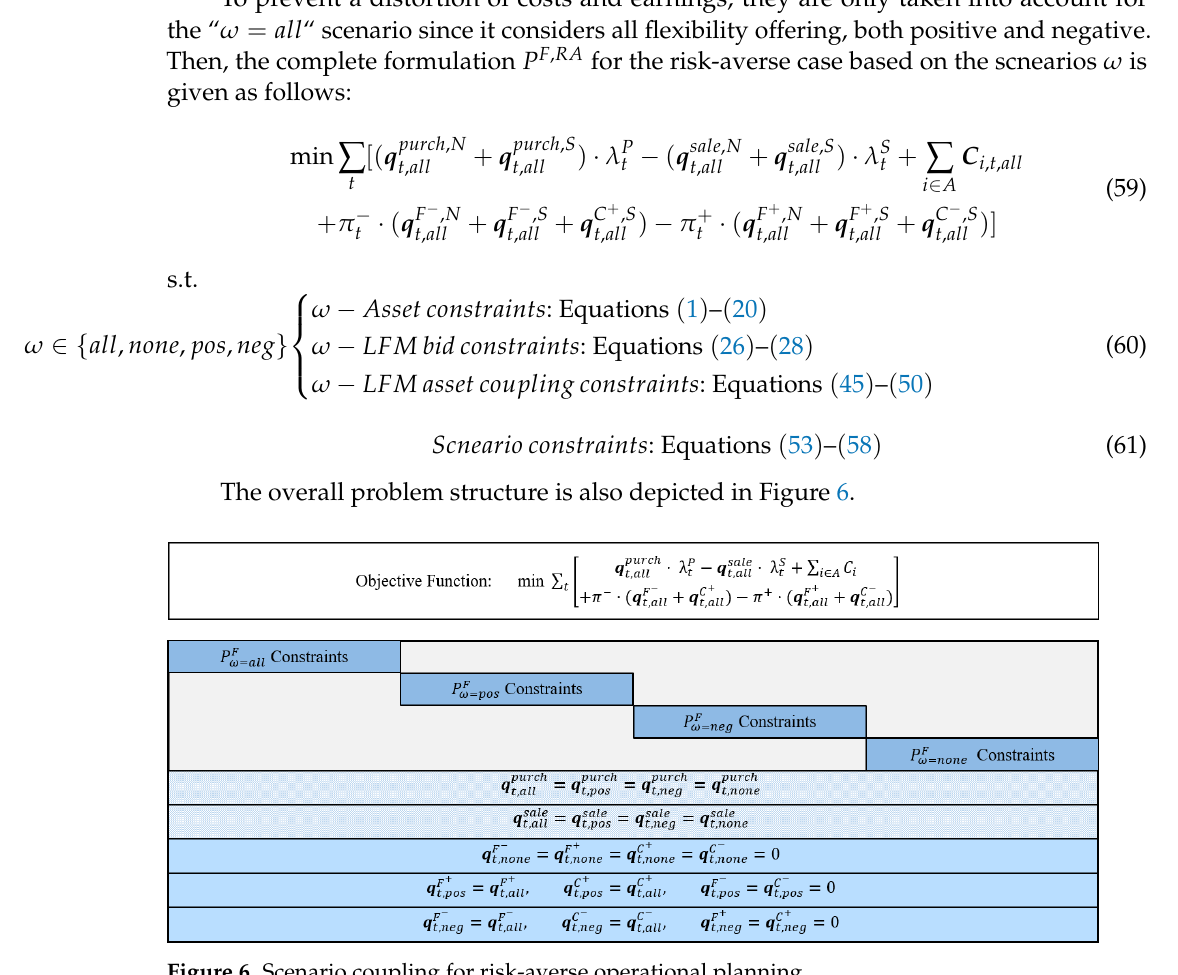
Figure 6. Scenario coupling for risk-averse operational